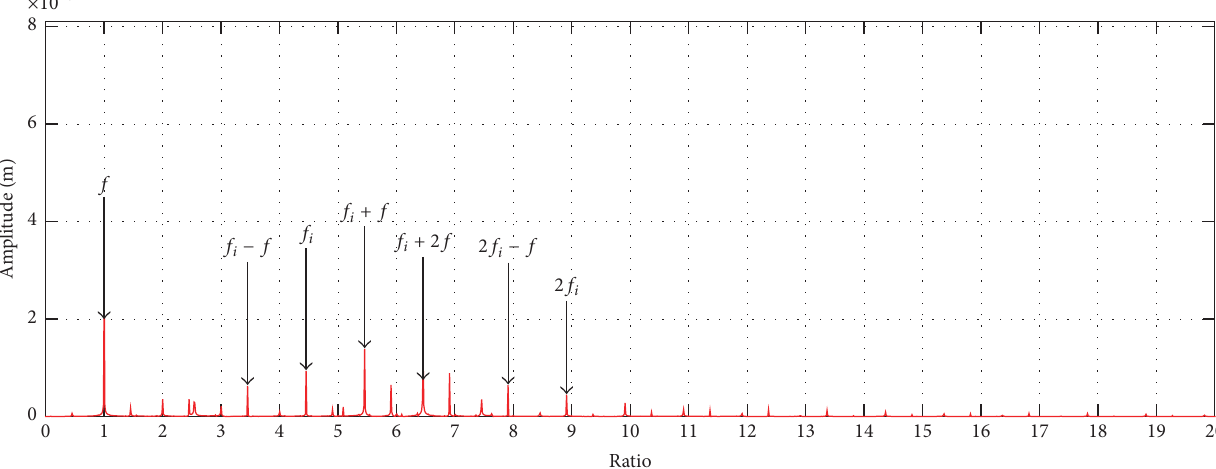
Figure 15: The spectral diagram of the faulted system with SFD mounted on the faulted bearing at 𝜔 = 150